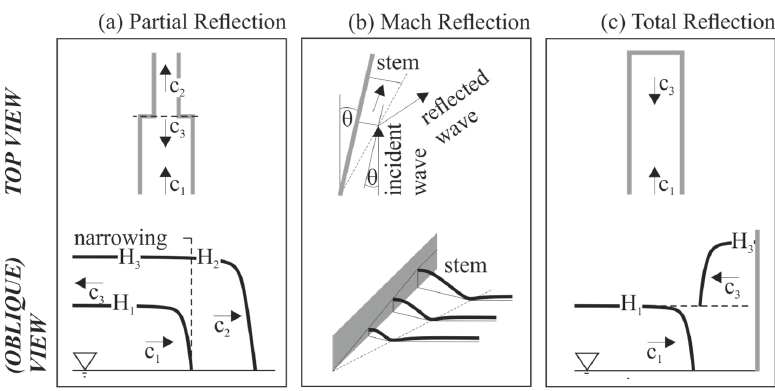
Figure 1. Top view and side/oblique view of partial reflection ( a ); Mach reflection ( b ) and total reflection ( c ) [13,14]. reflection ( c )